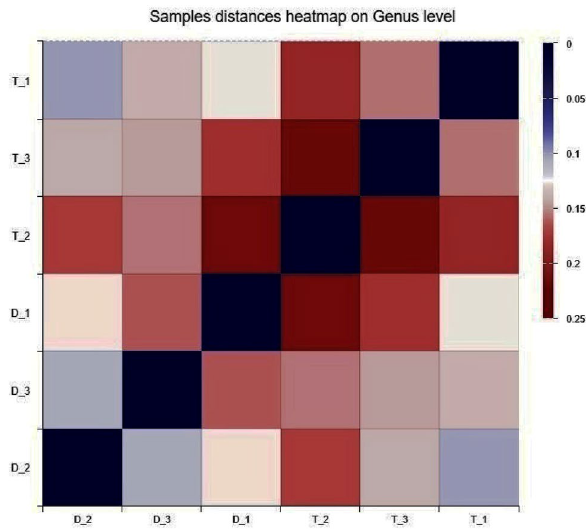
Figure 6. Distance dissimilarity heatmap on Genus level of Bray–Curtis dissimilarity matrix of Single and interplant groups (T_1, T_2, T_3 represents single Treatments, while D_1, D_2 and D_3 represent interplant treatments). According to the standard protocols by Majorbio Bio Pharm Technology Co. Ltd. (Shanghai, China), using Sanger software (https ://www.i-sange